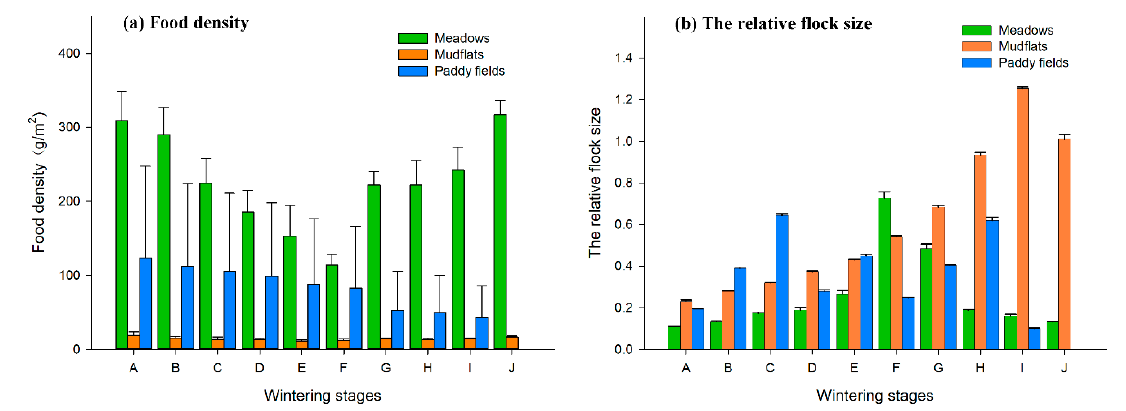
Figure 2. Dynamic changes of food density ( a ) and ratio of the number of hooded cranes to the number of geese ( b ) during wintering at Shengjin Lake (A–J stand for wintering stages, and their meaning is shown in Section 2.2).